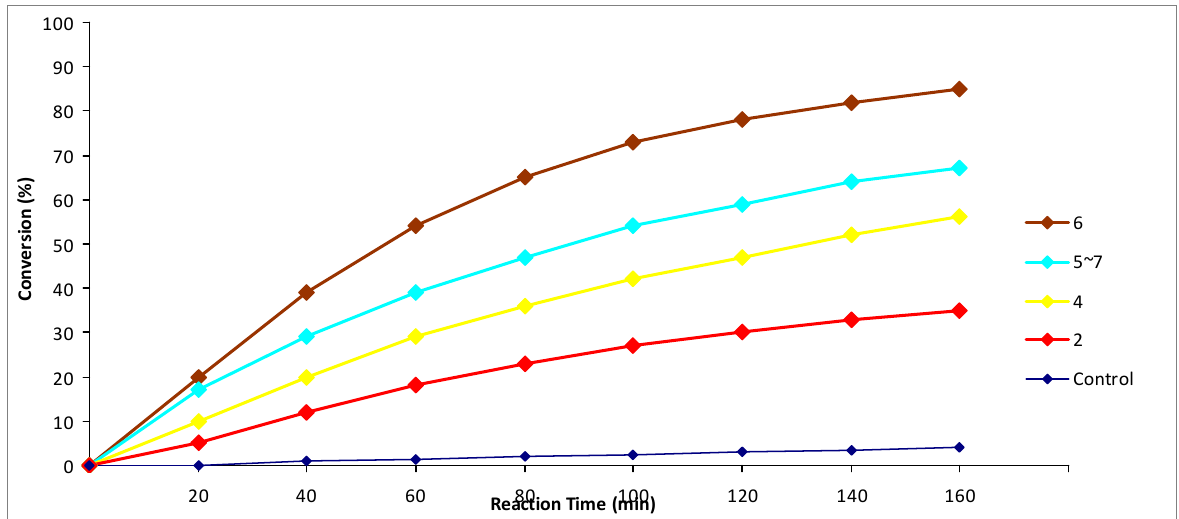
Figure 2. The assessment of glutathione peroxidase-like activity of bis(2-chlorovinyl) selenides 2 , 4 – 7 by 1 H-NMR monitoring.